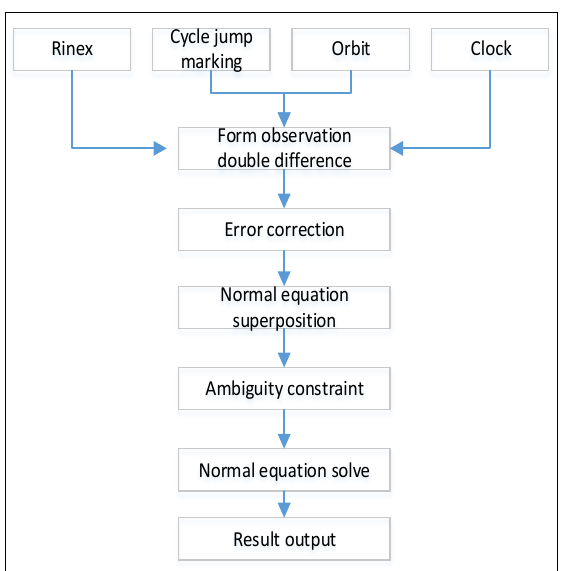
Figure 2 . Parameter estimation